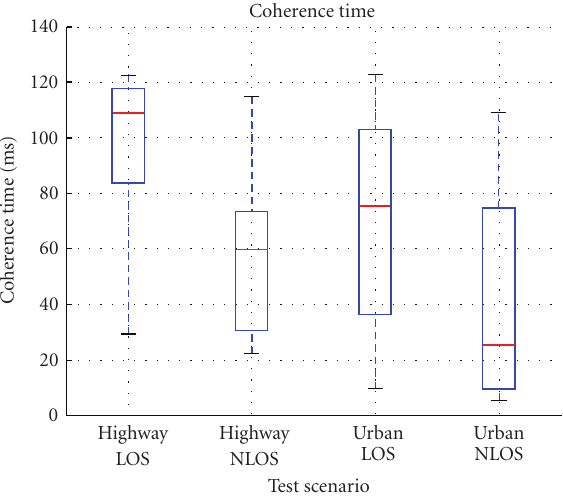
Figure 7: Comparison of coherence times for various scenarios.